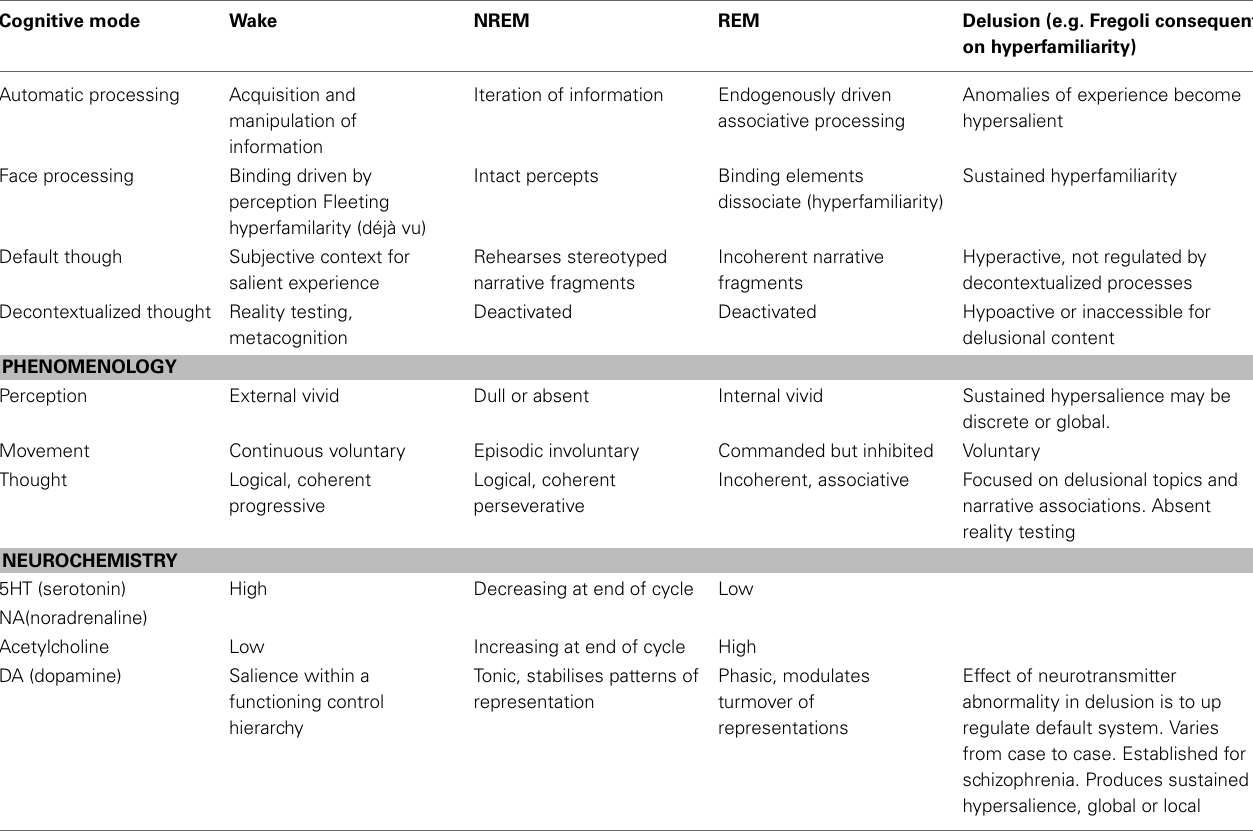
Table 1 | Summarizing cognitive similarities and differences between dreams and